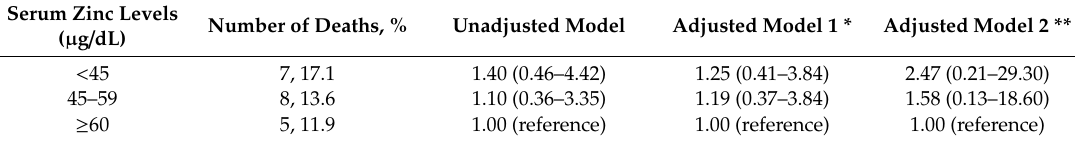
Figure 3. Kaplan–Meier estimates and Log rank test for all-cause mortality ( a ) and cardiovascular disease (CVD)-free ( b ) rates among baseline serum zinc levels. Table 4. Relationship between baseline serum zinc levels and hazard ratios of cardiovascular events. Serum Zinc Levels ( µ g /